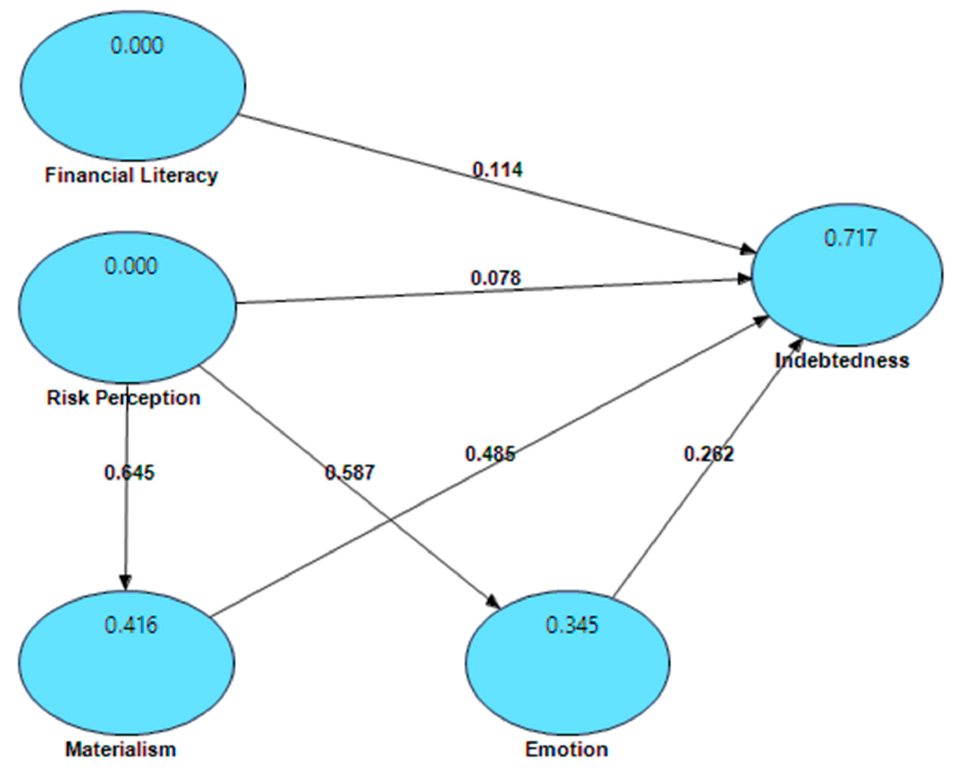
Figure 2. Measurement model.